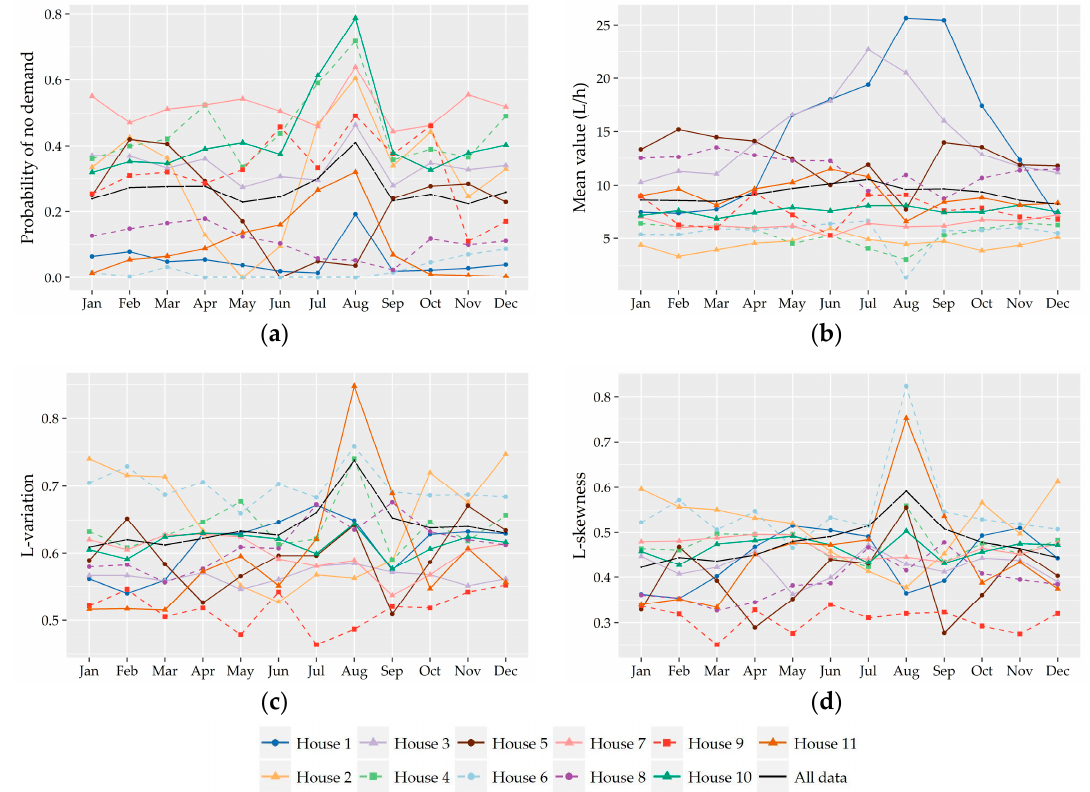
Figure 3. Hourly Scale : Variation per month of the probability of no demand ( a ), mean value ( b ), L-variation ( c ), and L-skewness ( d ) of the hourly nonzero demand records analyzed.